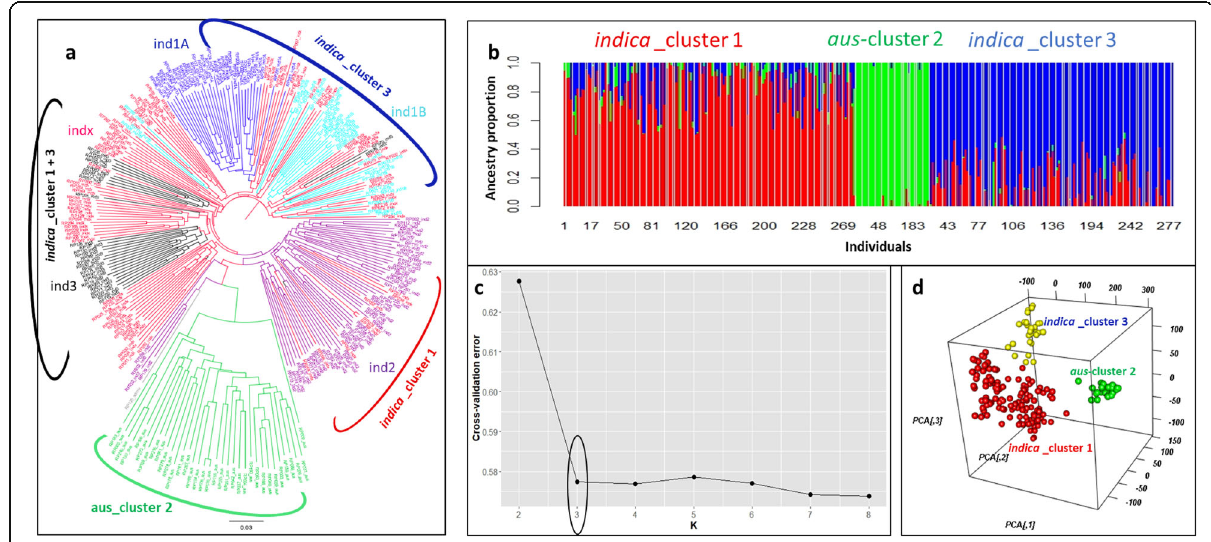
Fig. 3 Genetic relatedness and population structure of the diversity panel; a Genetic diversity depicted through the unweighted neighbour- joining tree method within the population as indica (ind 1A, ind 1B, ind 2, ind 3 and indx) and aus accessions, as established in the 3k rice genome project; b Ancestory proportions from ADMIXTURE analysis represented for k = 3, the optimal with the lowest cross-validation error for K = 2 – 8 and visualized using R/pophelper package; c Cross-validation error for k = 2 – 8 from ADMIXTURE analysis; d Variation captured by the PCs using R/ GAPIT corresponding to the 3 clustered distribution along the first three PC